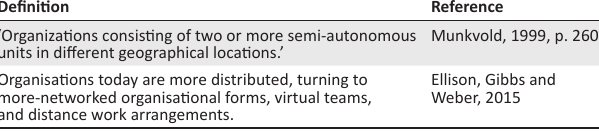
TABLE 7: A selection of definitions for distributed organisation.